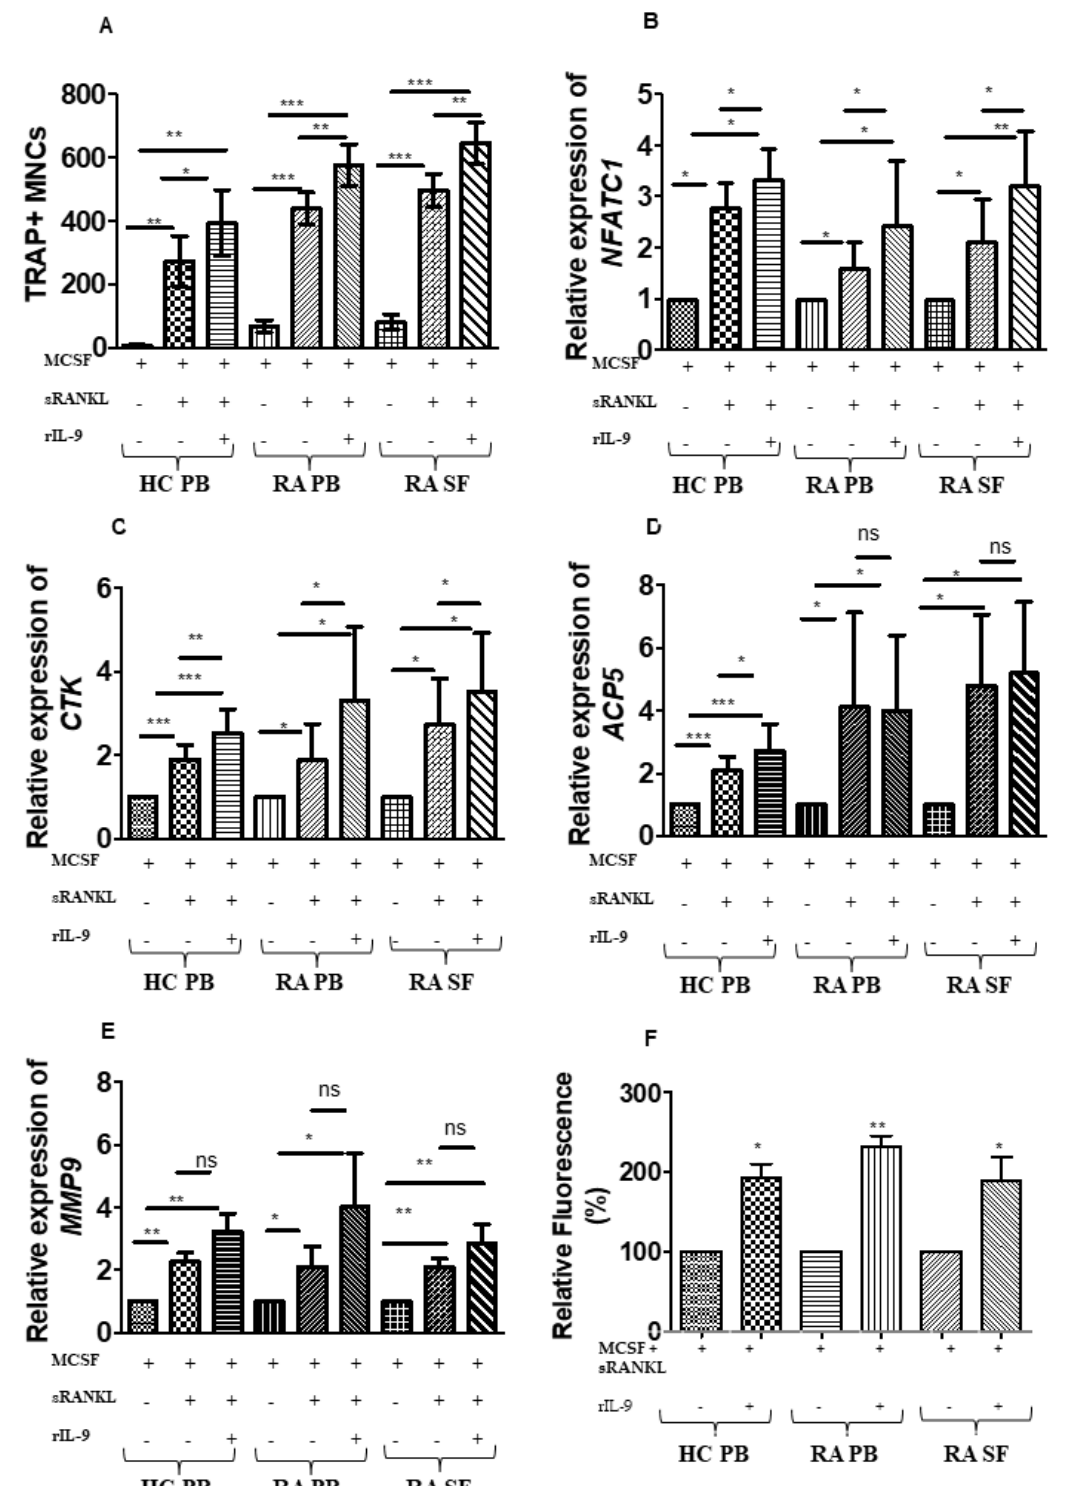
Figure 1. Interleukin (IL)-9 enhances osteoclast formation and function in cells derived from RA and HC. ( A ) Cells derived from peripheral blood (PB) of healthy control (HC); cells derived from PB and synovial fluid (SF) of patients with RA were treated as indicated with macrophage colony-stimulating factor (M-CSF; 25 ng/mL), soluble receptor activator of nuclear factor κ B ligand (sRANKL; 50 ng/mL), or IL-9 (100 ng/mL) for 21 days. Half of the culture medium was replenished with fresh culture medium containing stimulating factors (M-CSF, sRANKL, and rIL-9) at 4-day intervals. Cells were then fixed and stained for tartrate-resistant acid phosphatase (TRAP). Using a light microscope, multinucleated ( ≥ 3 nuclei) TRAP+ cells were counted manually. Graph shows TRAP+ multinucleated cells (MNCs) (mean ± SD; n = 5). Statistical analysis was performed using paired Student’s t -test comparing M-CSF/sRANKL/rIL-9-treated cells to M-CSF/sRANKL, M-CSF, or M- CSF/sRANKL-treated cells to M-CSF (*: p ≤ 0.05; **: p ≤ 0.005; ***: p ≤ 0.0005). ( B – E ) Cells derived from PB of HC, PB,